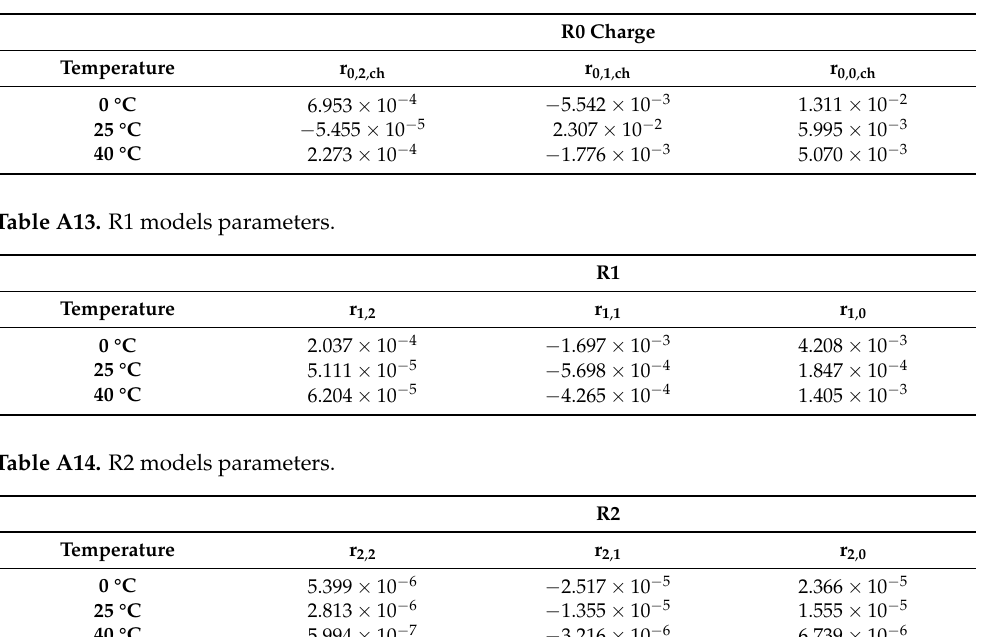
Table A12. R0 models parameters in charge.